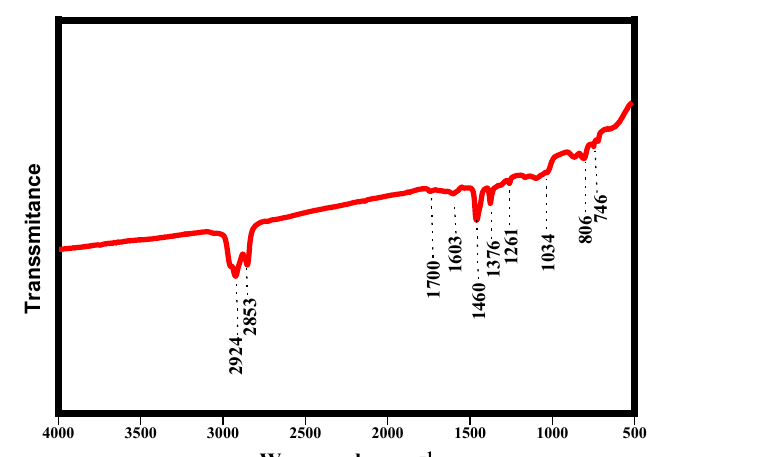
Figure 12. FTIR spectra of ( a ) R-modified asphalt, ( b ) P-modified asphalt, ( c ) (1% R + 5% P), (4% R + 10% P), and (7% R + 10% P)-modified asphalt.